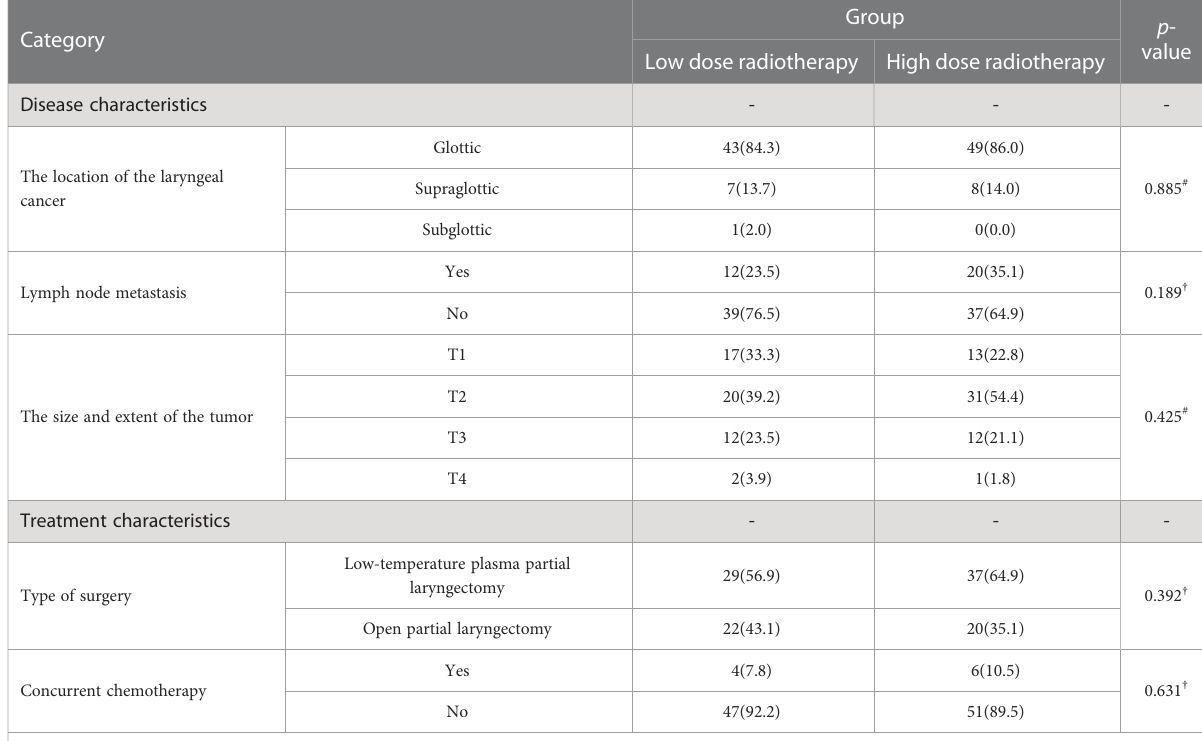
TABLE 2 Disease characteristics and treatment characteristics of the two